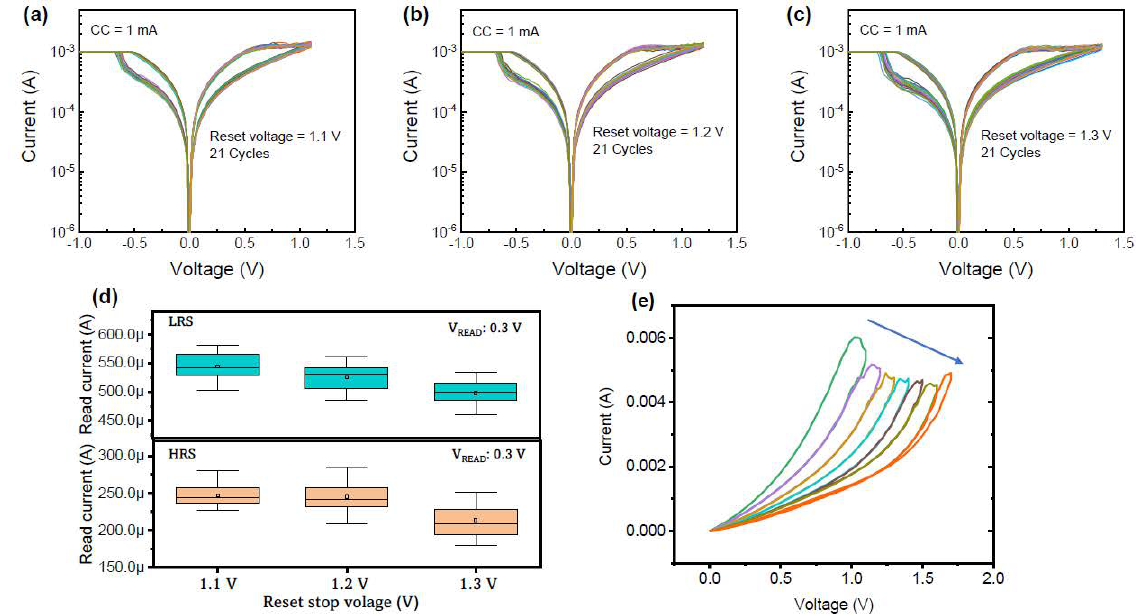
Figure 3. I–V characteristics of the Pt/TiO 2 /HfAlO x /TiN RRAM device at reset stop voltages of ( a ) 1.1 V, ( b ) 1.2 V, and ( c ) 1.3 V. ( d ) Read current distribution as a function of reset stop voltage. ( e ) MLC by reset stop